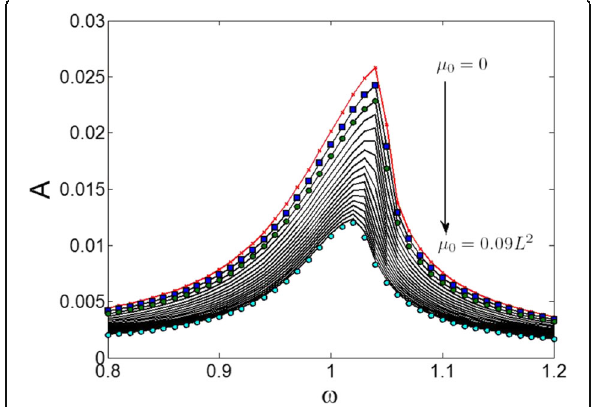
Fig. 3 Calculated non-dimensionalised displacement versus the driving frequency of the nanowire resonator